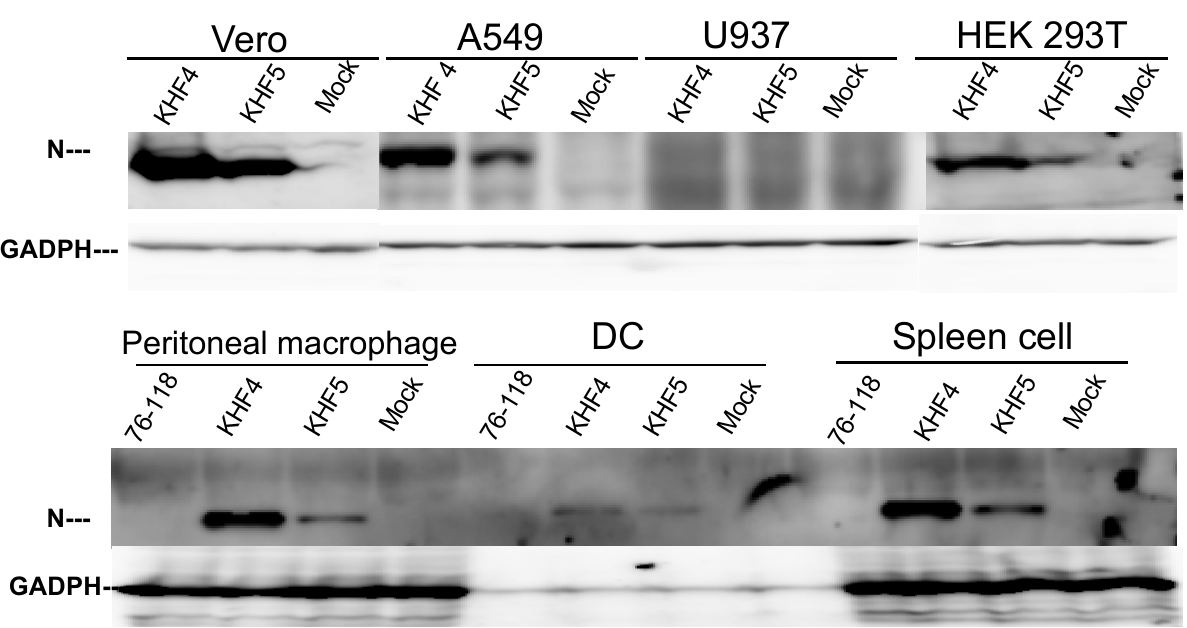
Figure 2. Cell tropism of KHF4 and KHF5 in vitro. Viral N protein production was compared by Western blotting to clarify virus replication in various cells. Four cell lines, (Vero E6, A549, U937, and HEK 293T) and peritoneal macrophages, dendritic cells (DC), and spleen cells obtained from five-week-old BALB/c mice were inoculated at a MOI of 0.1 and cultured for 5 days. GAPDH was used as the reference protein.